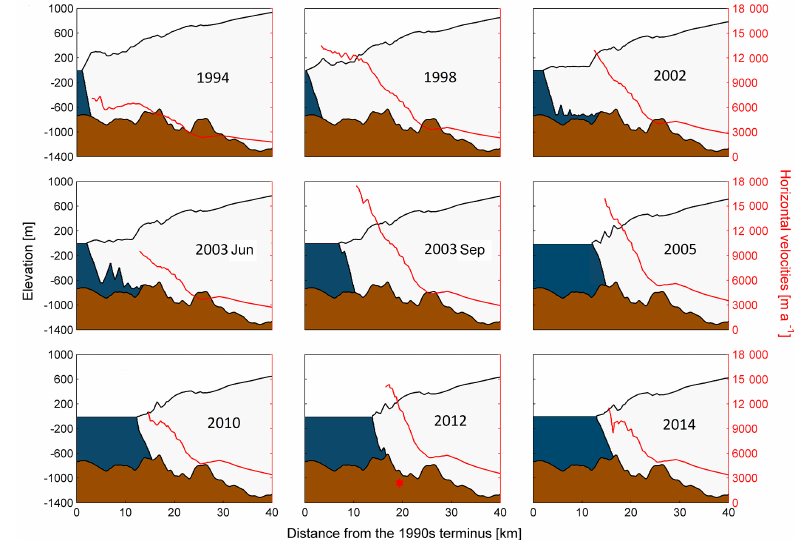
Figure 6. Modelled evolution of surface elevation (floating ice tongues thinner than 50m are not shown) and horizontal velocities of Jakob- shavn Isbræ for December along the flow line shown in Fig. 1c. Note the acceleration in speed between 1994 and 1998 and between June 2003 and September 2003 corresponding to the final break-up of the floating tongue. The red star denotes the observed 2012 terminus